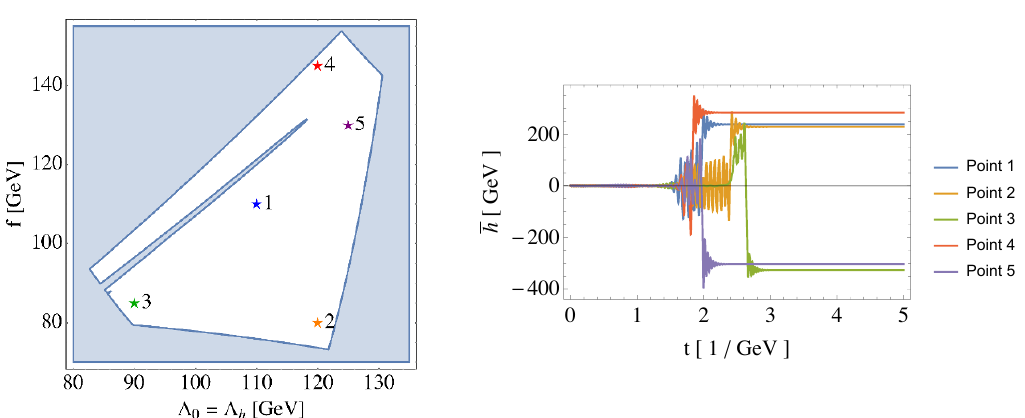
Figure 9 . The evolution of the Higgs (cid:12)eld for each sample point. The locations of sample points are shown in the left panel. For each point, the evolution of the Higgs (cid:12)eld is shown in the right